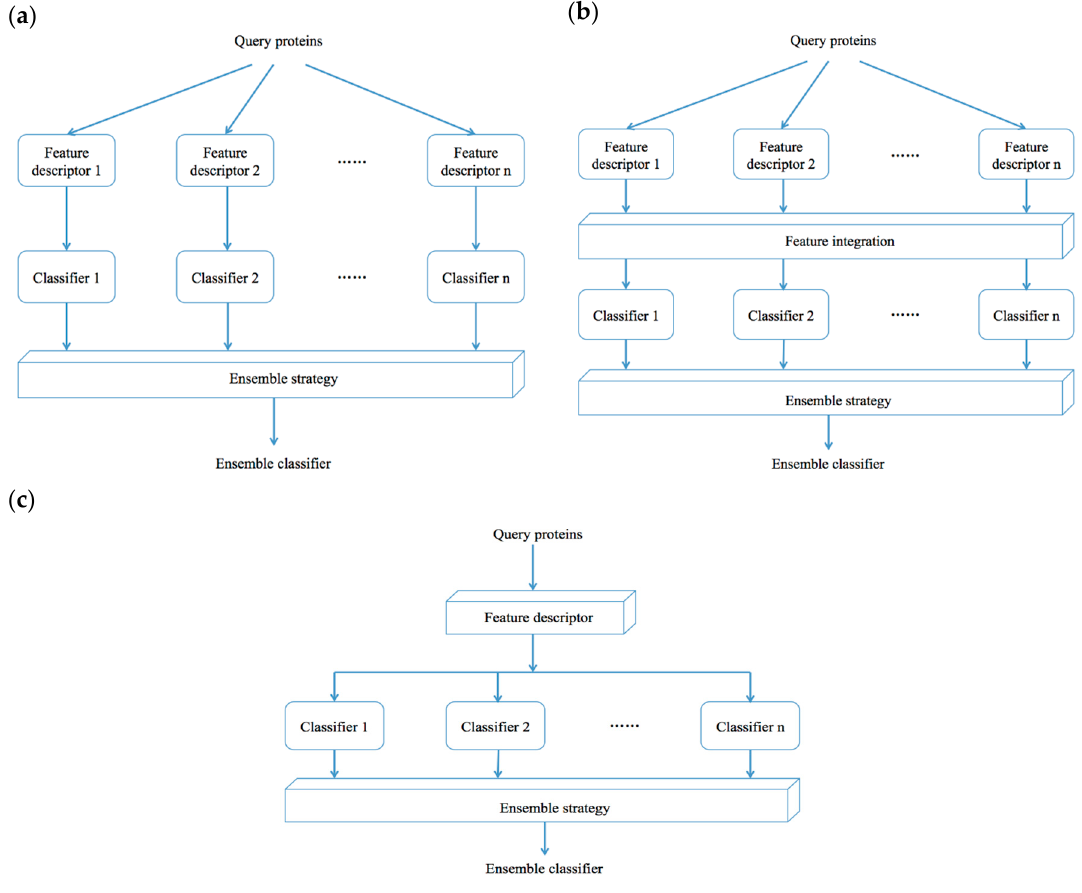
Figure 3. Construction types of ensemble-classifier models.